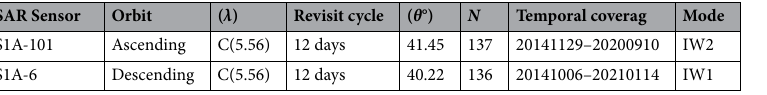
Table 1. Details of the SAR images used for the InSAR time-series analysis. θ Incidence angle of the sensor. N Number of processed epochs.